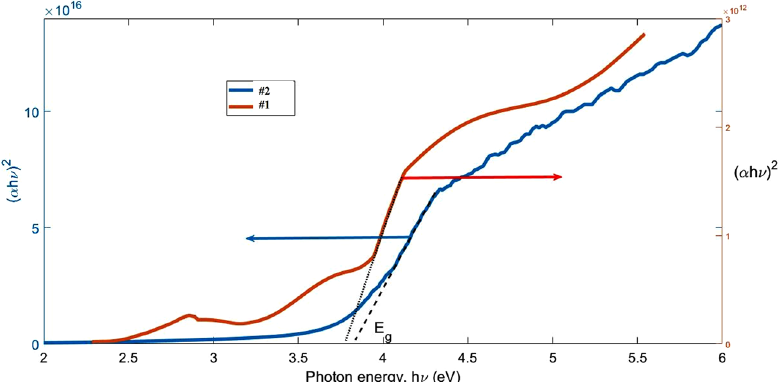
Figure 10. Determination of optical gap band of NiO thin films on silicon (#1) and quartz (#2) substrates.